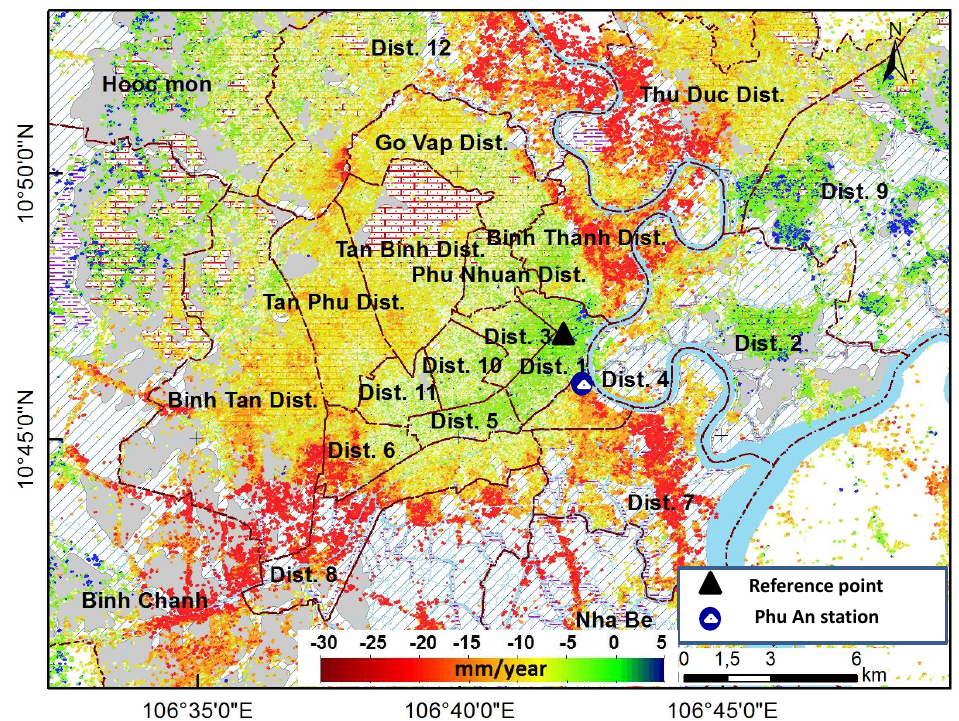
Figure 5. The average velocity trend from 2006 to 2010. Positive velocities (blue colors) represent movement uplift; negative velocities (red colors) represent movement subsidence. The background is the geology layer; see the legend in Figure